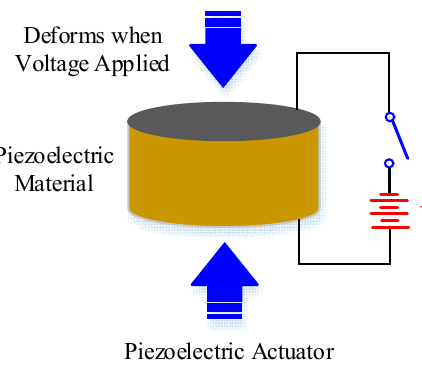
Figure 8. Typical example of piezoelectric actuators.